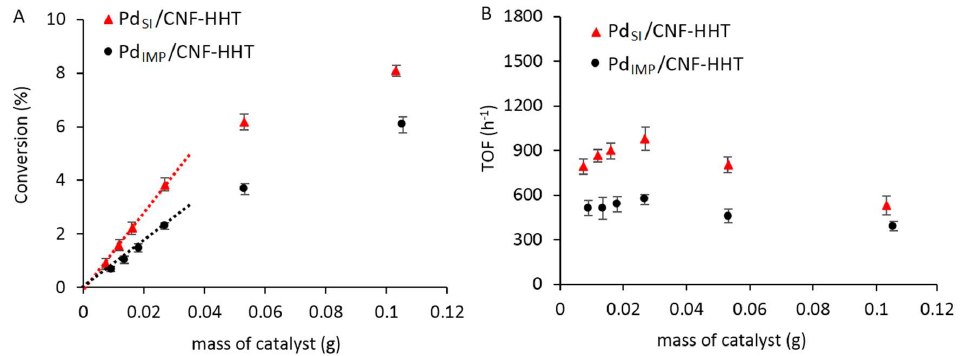
Figure 6. Effect of catalyst mass on (A) Conversion of formic acid dehydrogenation, ( B ) TOF. Reaction conditions: 30 °C, 0.5 M HCOOH, 750 rpm, and 2 h reaction time.